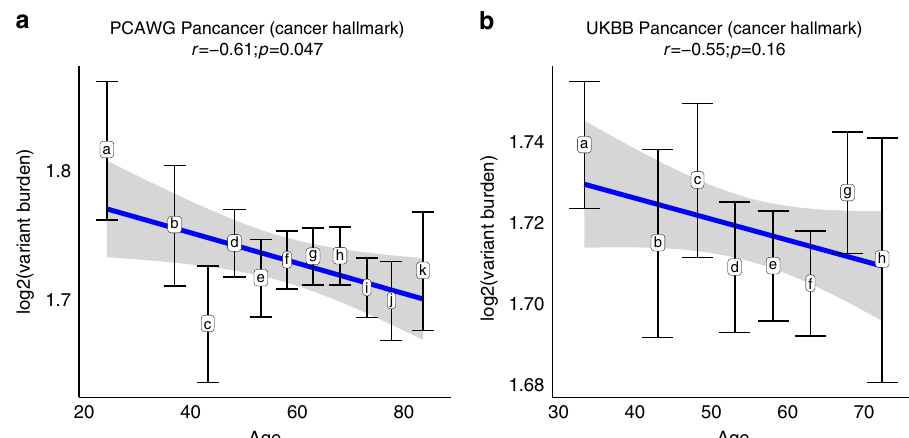
Fig. 3 Correlation between gHFI variant burden in cancer genes in the PCWAG and UKBB. a Variant burden for 11 age intervals in the PCAWG ( n = 1487 cases, the tags a – k correspond to ages ≤ 30, 31 – 40, 41 – 45, 46 – 50, 51 – 55, 56 – 60, 61 – 65, 66 – 70, 71 – 75, 76 – 80, and ≥ 81). b Variant burden in eight age intervals in the UKBB ( n = 7198 cases, the tags a – h correspond to ages ≤ 40, 41 – 45, 46 – 50, 51 – 55, 56 – 60, 61 – 65, 66 – 70, and ≥ 71). The y -axes show the log 2 transformed variant/mutation burden. Error bars represent standard error. The r represents Pearson correlation coef fi cient. Spearman ’ s Rho test (two- sided) was used to generate the p -value to measure the strength of correlation coef fi cient.